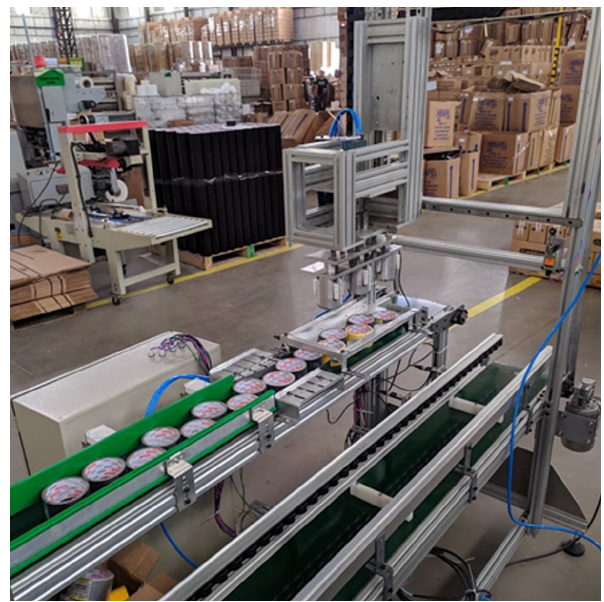
Figure 10. Guzzetti machine installed.